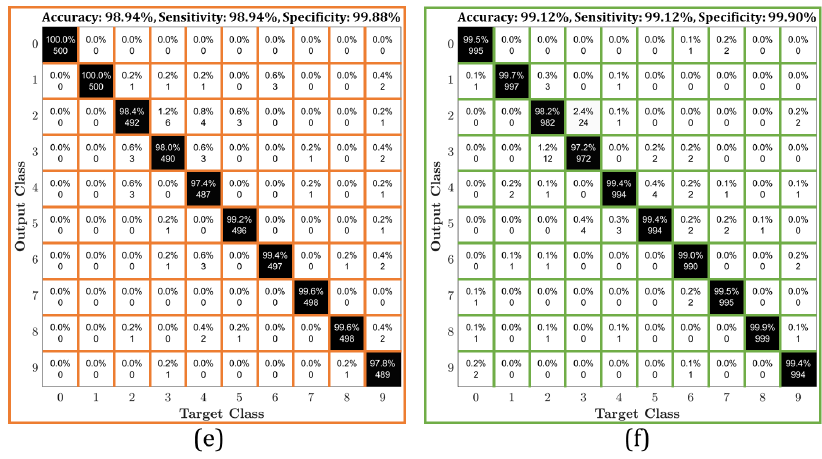
Figure 6. Confusion matrix of the numeral recognition system using ( a ) polynomial kernel for Roman dataset, ( b ) polynomial kernel for Arabic dataset, ( c ) polynomial kernel for Devanagari dataset, ( d ) RBF kernel for Roman dataset, ( e ) RBF kernel for Arabic dataset, and ( f ) RBF kernel for Devanagari